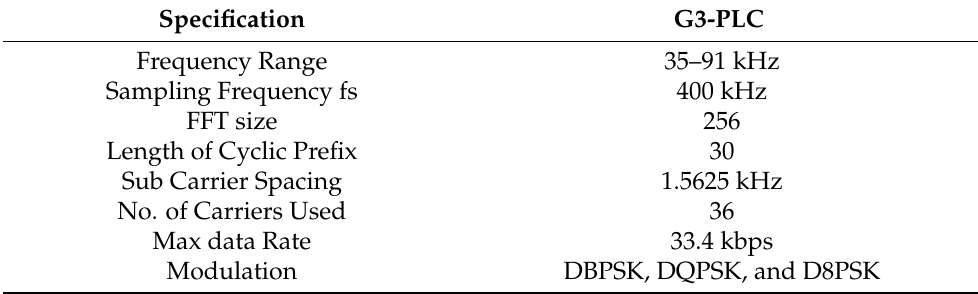
Table 1. G3-PLC specifications.